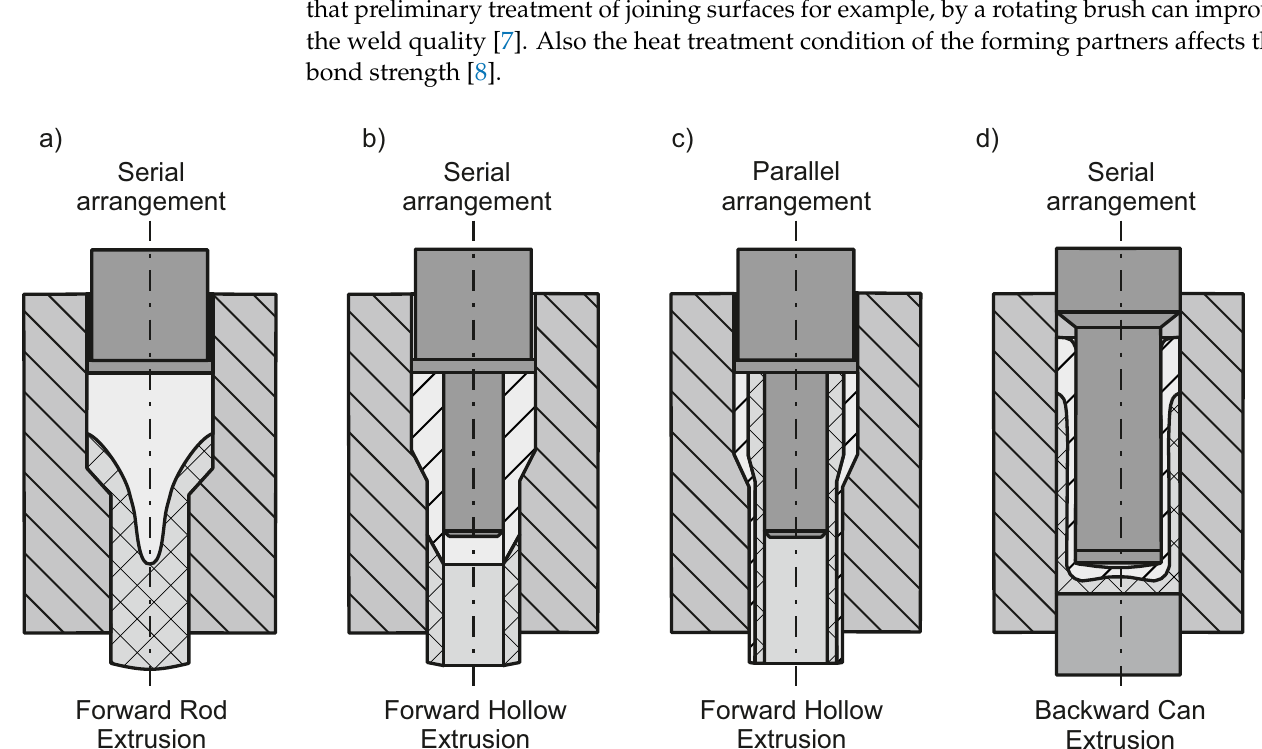
Figure 1. Cold forging processes and arrangement of materials in used composite billets. ( a – c ) representing works by Gumm [1] and ( d ) investigations by Wagener and Haats